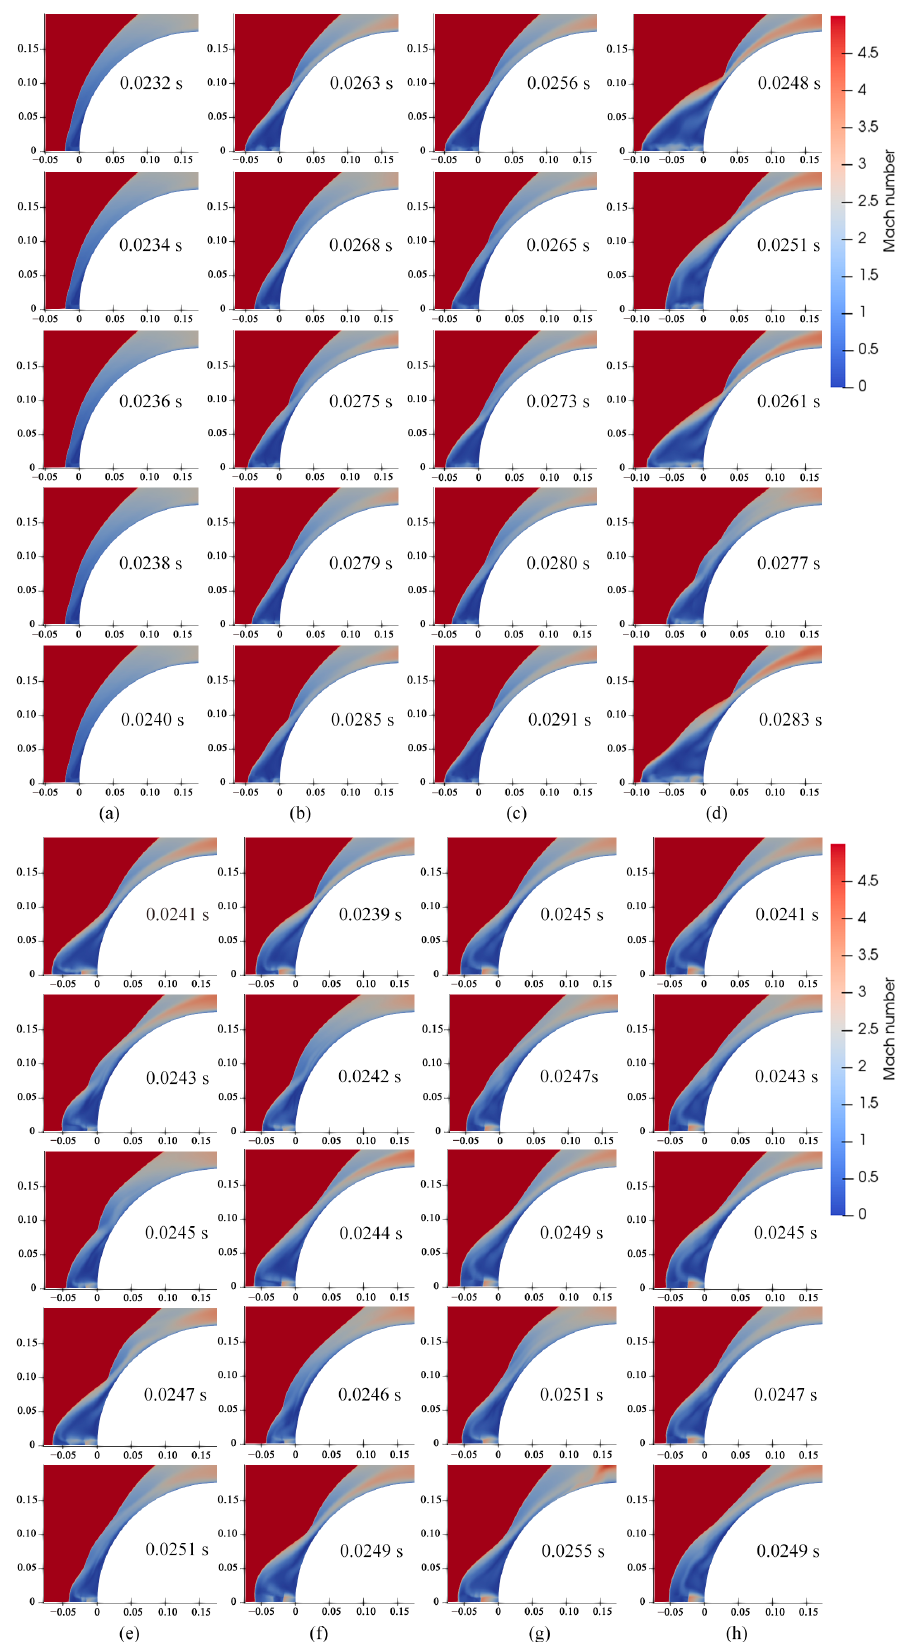
Figure 5. Mach numbers of R7 jet at different times: ( a ) case 1 ( b ) case 2, ( c ) case 3, ( d ) case 4, ( e ) case 5, ( f ) case 6, ( g ) case 7, ( h ) case